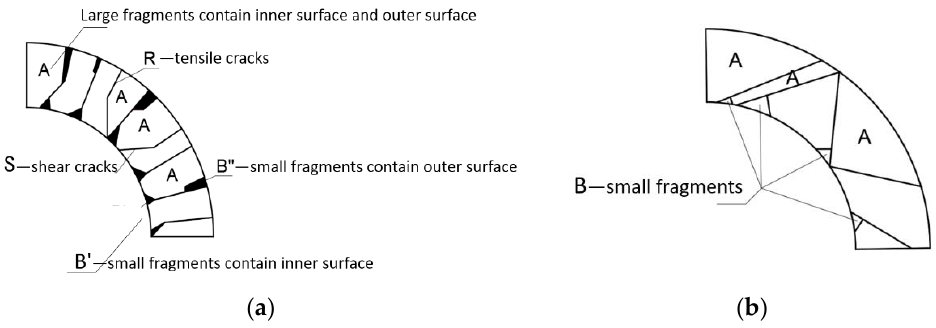
Figure 1. Main fragments: “A”— large fragments contain inner surface and outer surface and “B”— small fragments only contain one surface of the cylindrical shell; ( a ) tensile – shear mixed fracture mode; ( b ) pure shear fracture mode.